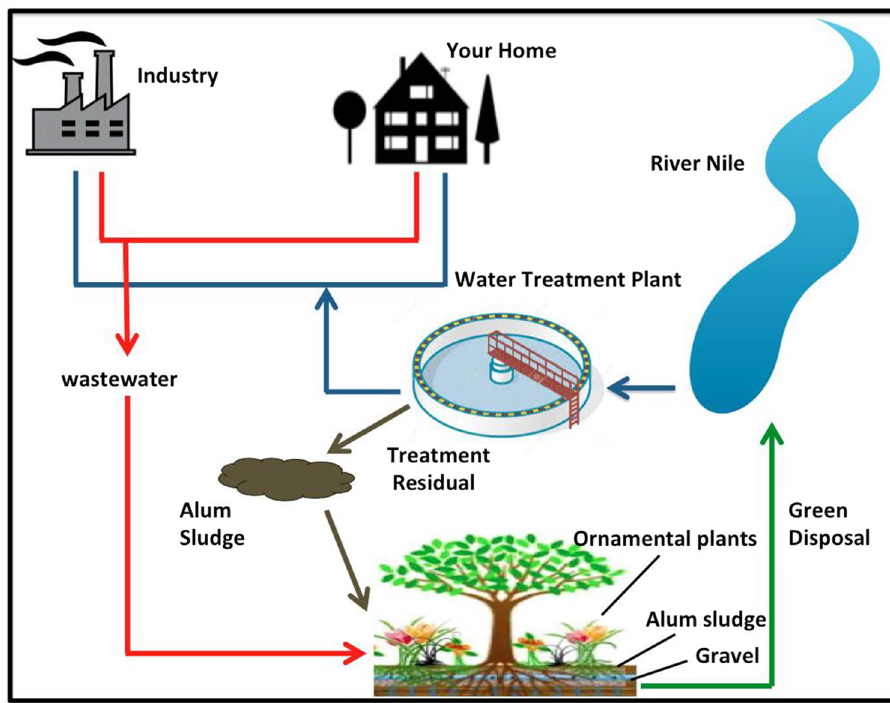
Fig. 7 Lifespan of alum sludge from source to use in con- structed wetlands